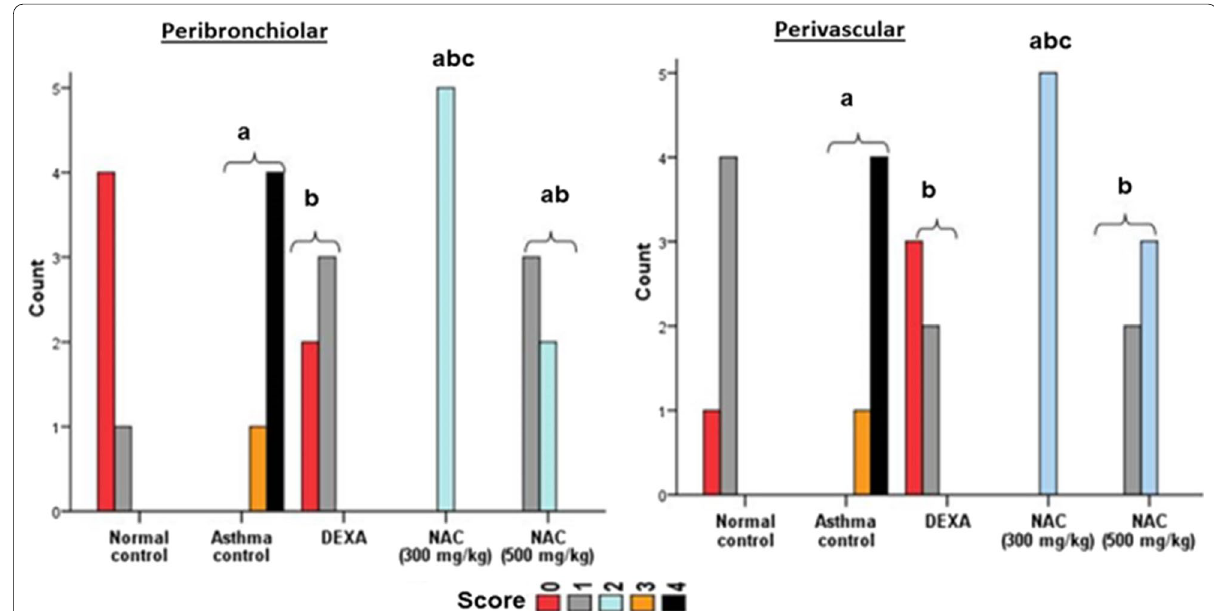
Fig. 4 Peribronchiolar and perivascular inflammation score ( N 5). The Chi‑square test was performed at p < 0.05. a at p < 0.05, considered = significantly different from normal control. b at p < 0.05, considered significantly different from asthma control group. c at p < 0.05,